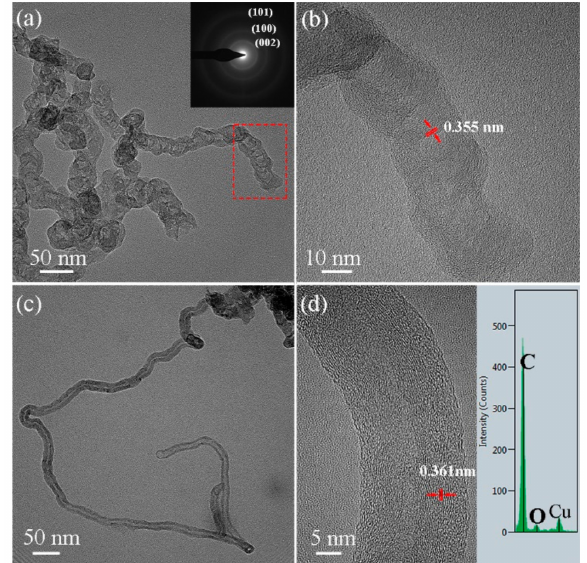
Figure 10. TEM and HRTEM images of samples with 5 wt.% GNPs / PF with 1 wt.% Ni(NO 3 ) 2 · 6H 2 O. ( a , b ) Shows the bamboo-like chains of carbon nanotubes (CNTs) (the inset in ( a ) shows the selected-area electron di ff raction (SAED) pattern), ( c , d ) shows hollow CNTs (the inset in ( d ) shows the energy-dispersive spectroscopy (EDS)